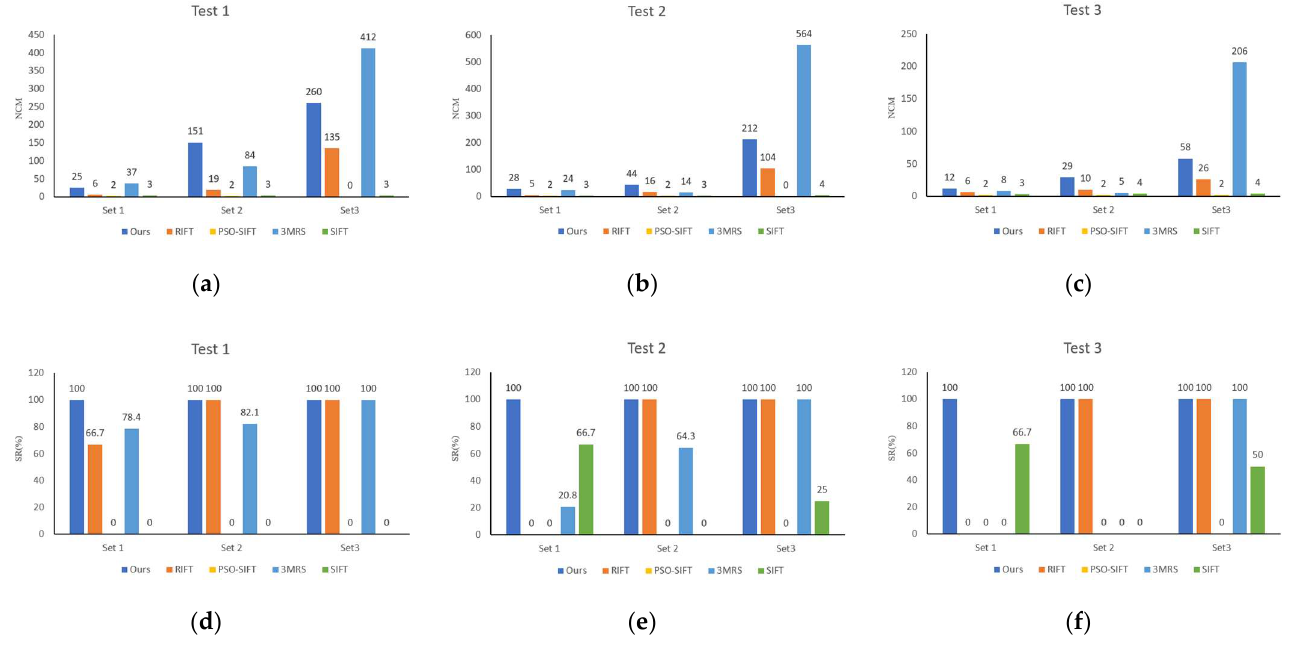
Figure 10. Comparisons on NCM and SR metrics. ( a – c ) The number of corresponding feature points extracted on three test data by five methods; ( d – f ) The success rate of corresponding feature points extracted on three test data by five methods.